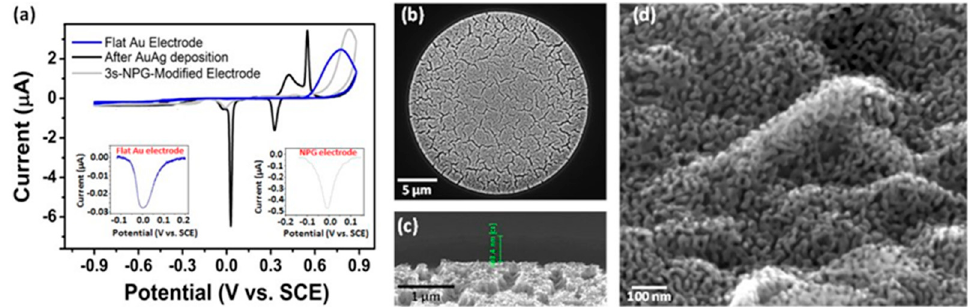
Figure 3. ( a ) CVs in 1 M NaOH at 10 mV s − 1 recorded at a gold microdisc array (blue), after Au 0.18 Ag 0.82 electrodeposition (black) and at an NPG-modified one (grey). Insets show gold oxide reduction peaks at bare gold- and NPG microdisc array electrodes (left and right, respectively); ( b ) plan view SEM image; ( c ) tilted SEM image of NPG microdisc; ( d ) high magnification SEM image of NPG structure.